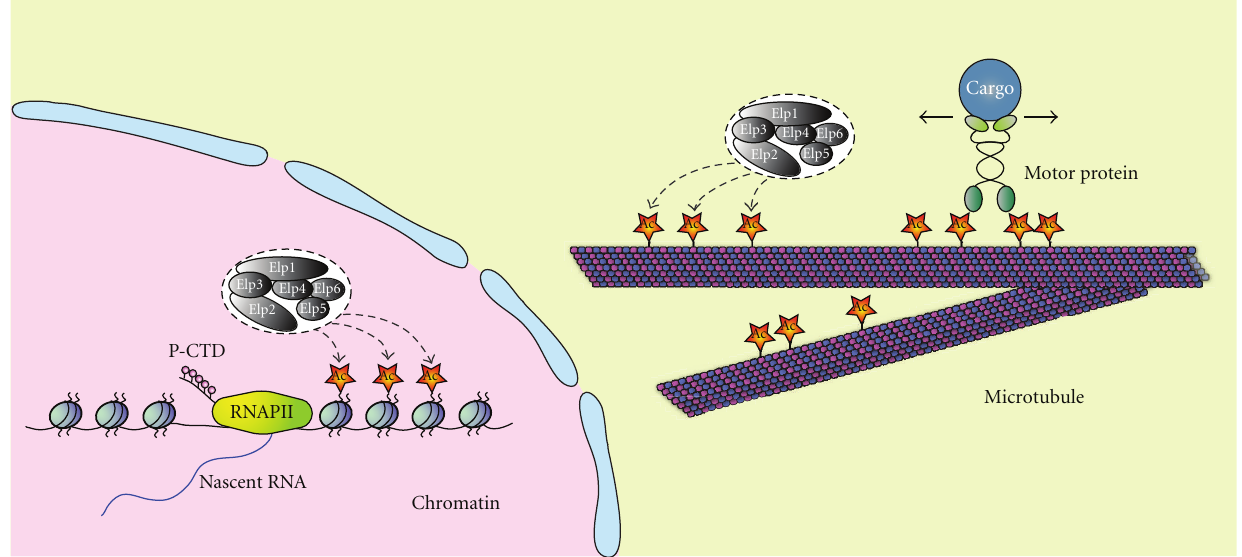
Figure 2: Two acetylation-dependent functions of Elongator. In the nucleus, Elongator-mediated acetylation of Histone H3 contributes to transcriptional elongation. Thereby, it interacts with processive RNAPII, which is hyperphosphorylated at its C-terminal domain (CTD). Although this function of Elongator is conserved from yeast to man, the subset of genes that underly this kind of regulation have diverged during evolution. In the cytosol, Elongator acetylates the α -Tubulin subunit of microtubules. This acetylation event contributes to the tra ffi cking of cargo along microtubules and cell migration. Please note that acetylation of α -Tubulin occurs in the lumen of microtubule, but for reasons of illustration, it has been depicted on outside